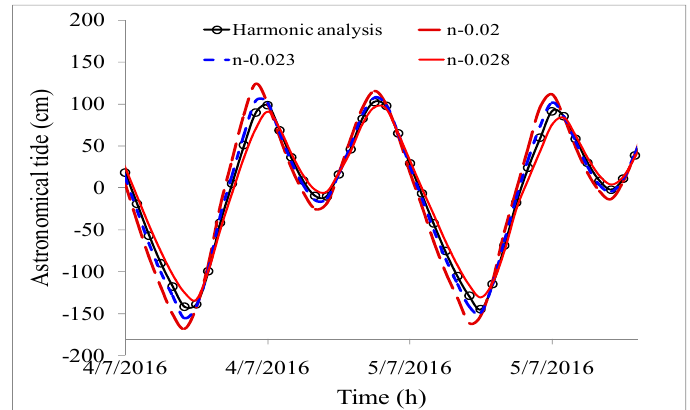
Figure 8. Comparison of tides predicted by two-dimensional Regional Ocean Model System (ROMS 2D) for three values of the Manning coefficient ( n )with harmonic analysis atVung Tau station in July 2016.